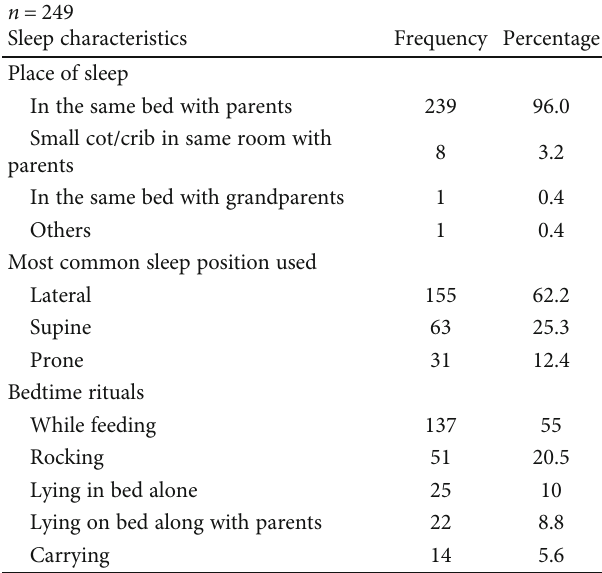
Table 2: Sleep characteristics of